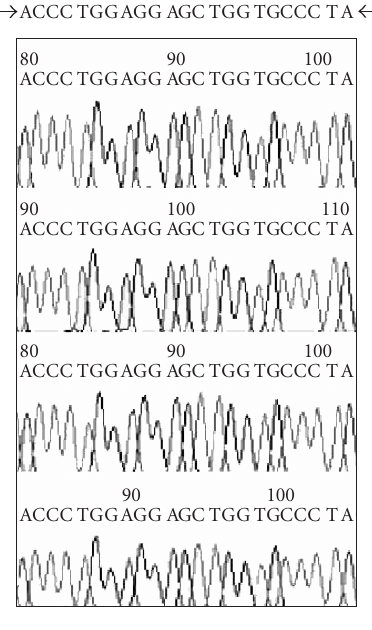
Figure 2: Representative results from 4 patients’ direct DNA se- quencing of PCR product for MEFV gene pyrin domain and wild type sequence of presented